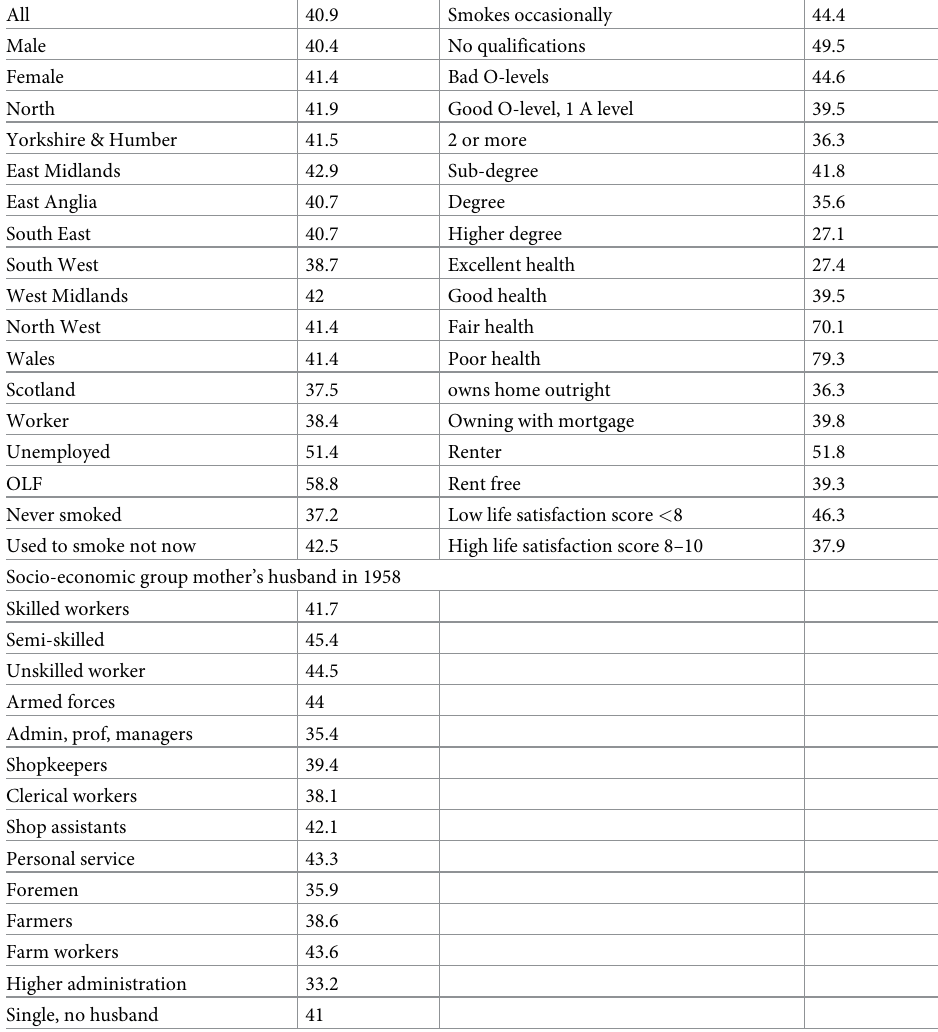
Table 5. Chronic Pain in BMS (age 44) and characteristics at age 46 and at birth %. All 40.9